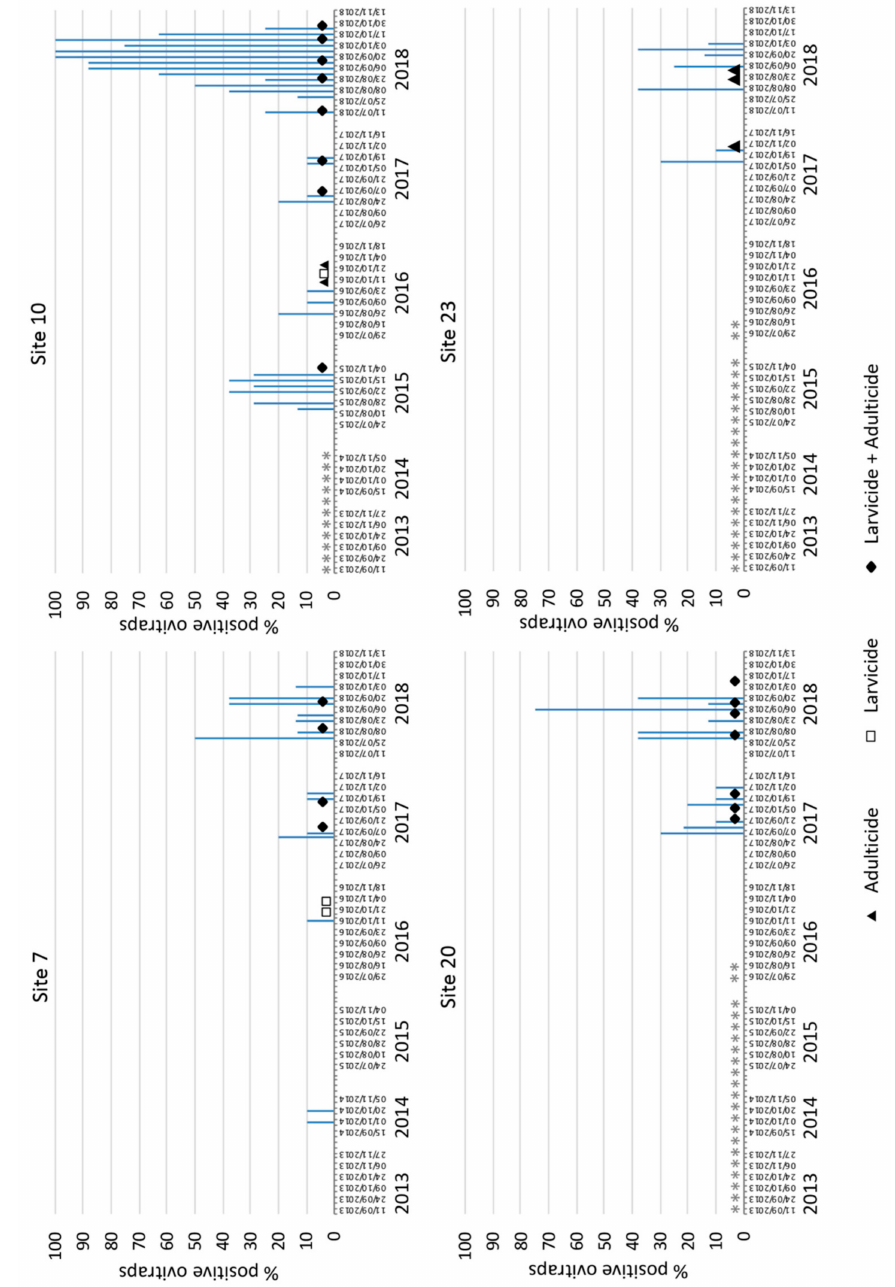
Figure 2. Percentages of positive ovitraps in the 4 sites where Ae. albopictus eggs were observed throughout the study and timing of treatments applied: Asterisks indicate dates when sampling was not